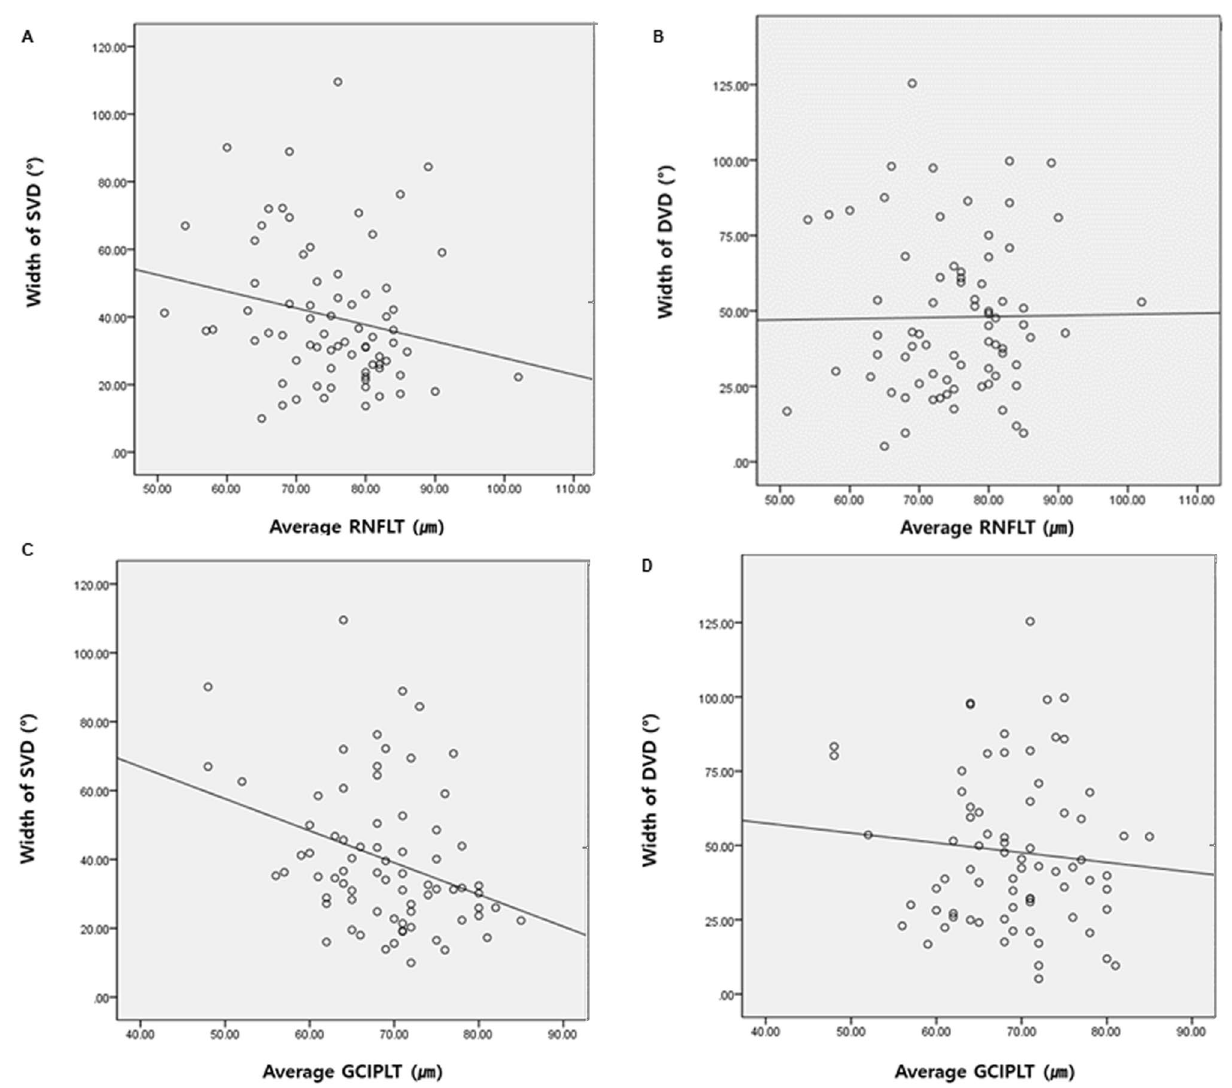
Figure 1. Relationship between the width of vessel density defect in superficial or deep layers and structural parameters, including average retinal nerve fiber layer thickness and average ganglion cell inner plexiform layer thickness. The correlation between the width of superficial vessel defect (SVD) and the average retinal nerve fiber layer thickness (RNFLT) ( A ) and average ganglion cell inner plexiform layer thickness (GCIPLT) ( C ) was substantially significant, compared to the correlation between the width of deep vessel defect (DVD) and average RNFLT ( B ) and average GCIPLT ( D ). Pearson correlation analysis was